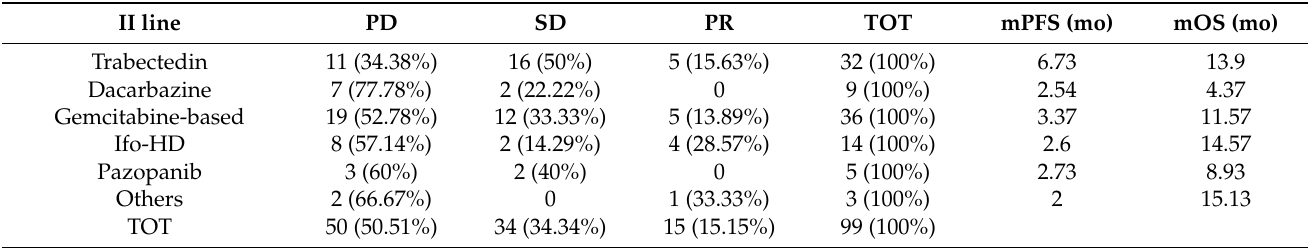
Table 2. Response rates, mPFS, and mOS to each second-line